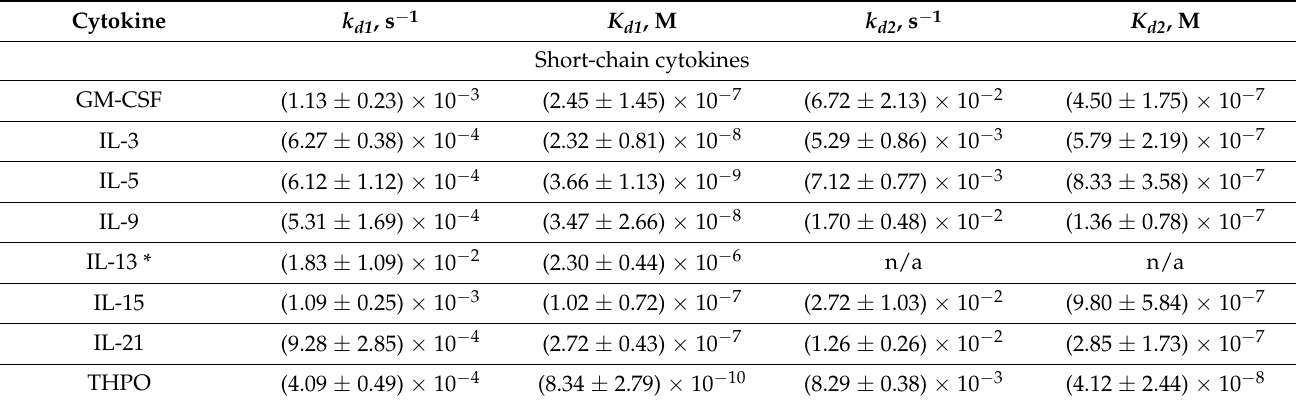
Figure 1. Kinetics of the interaction of Ca 2+ -loaded S100P with specific short-chain four-helical cytokines shown in Table 2 at 25 ◦ C, monitored by SPR spectroscopy using S100P as an analyte and the cytokines as a ligand immobilized on the sensor chip surface by amine coupling. ( A ): GM-CSF; ( B ): IL-3; ( C ): IL-5; ( D ): IL-9; ( E ): IL-13; ( F ): IL-15; ( G ): IL-21; ( H ): THPO. Buffer conditions: 10 mM HEPES, 150 mM NaCl, 1 mM CaCl 2 , 0.05% TWEEN 20, pH 7.4. The vertical dotted lines mark the association phase, followed by the dissociation phase. Molar analyte concentrations ( µ M) are indicated for the sensograms. The gray curves are experimental, while the black curves are theoretical, calculated according to the heterogeneous ligand model (1) or one-site binding model, in the case of IL-13 (see Table 3). Table 3. Parameters of the heterogeneous ligand model (1), describing the SPR data on kinetics of interaction between Ca 2+ -loaded S100P and specific four-helical cytokines shown in Table 2 at 25 ◦ C (see Figures